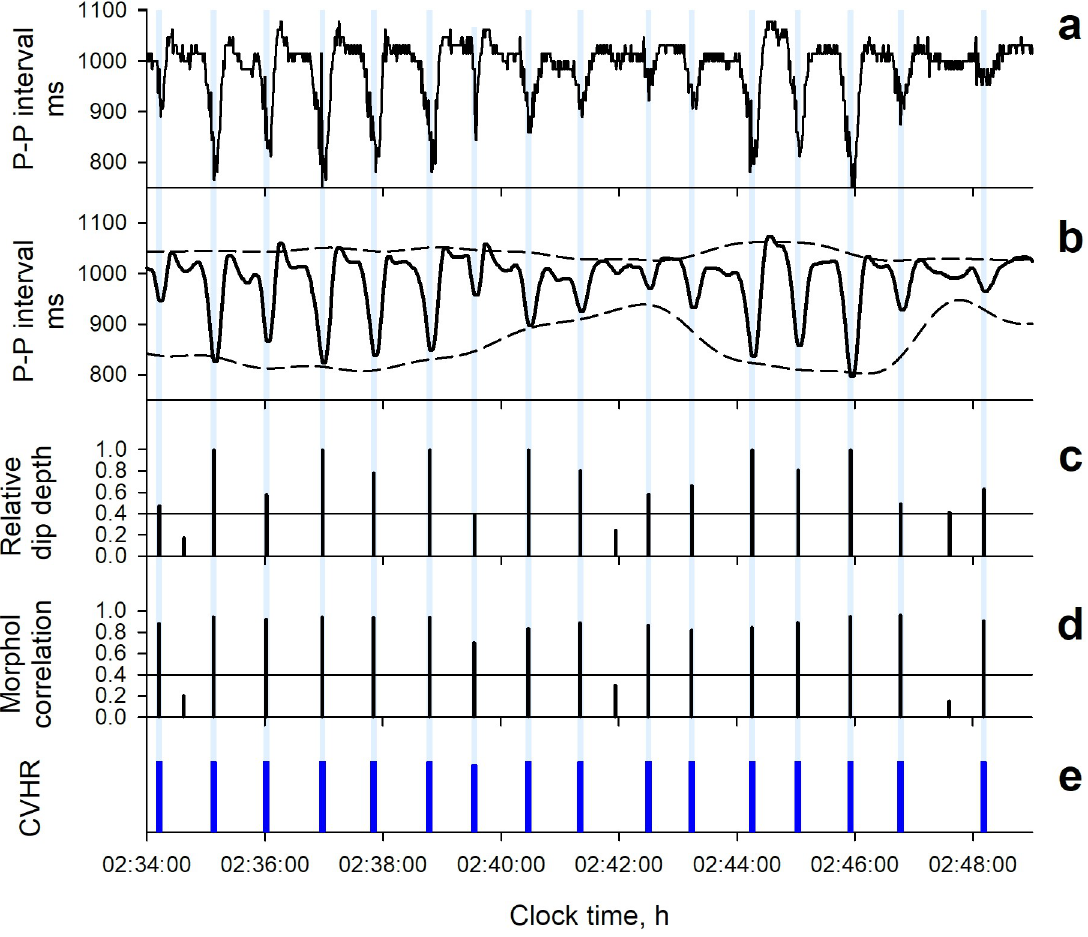
Fig 2. Detection of CVHR from photoplethysmography (PPG) pulse interval time series by the ACAT algorithm in a representative subject (a 66-y male with a body mass index of 27.0 kg/m 2 and an apnea-hypopnea index of 79.3). Panel a: original pulse interval time series. Panel b: second-order polynomial fitting line (solid line) and the upper and lower envelopes of the fitting line (dashed lines). Panel c: the relative dip depth to the envelope width at the time. Panel d: mean morphological correlation coefficients of dip with the two preceding and two subsequent dips. Panel e: temporal positions (blue bars) of dips detected as